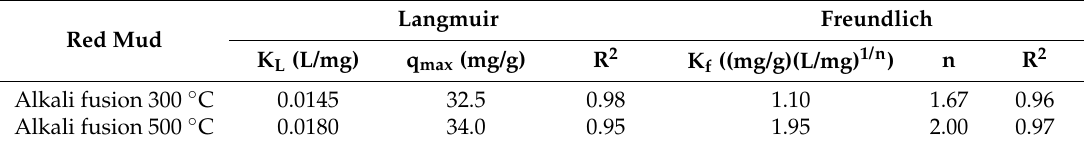
Figure 10. Arsenic adsorption isotherms with red mud obtained by alkali fusion at 300 and 500 °C: ( a ) Langmuir isotherm equation, ( b ) Freundlich isotherm equation. Table 4. Adsorption isotherms and the parameters most suitable to the data obtained.